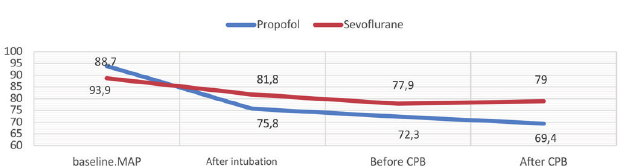
Figure 2 - Changes in mean arterial pressure before and during surgery.